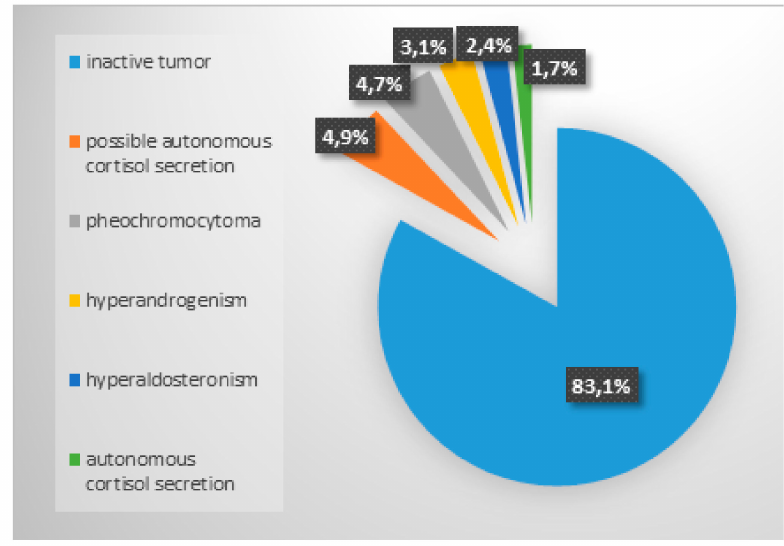
Figure 2. The results of hormonal activity assessment of adrenal incidentalomas.